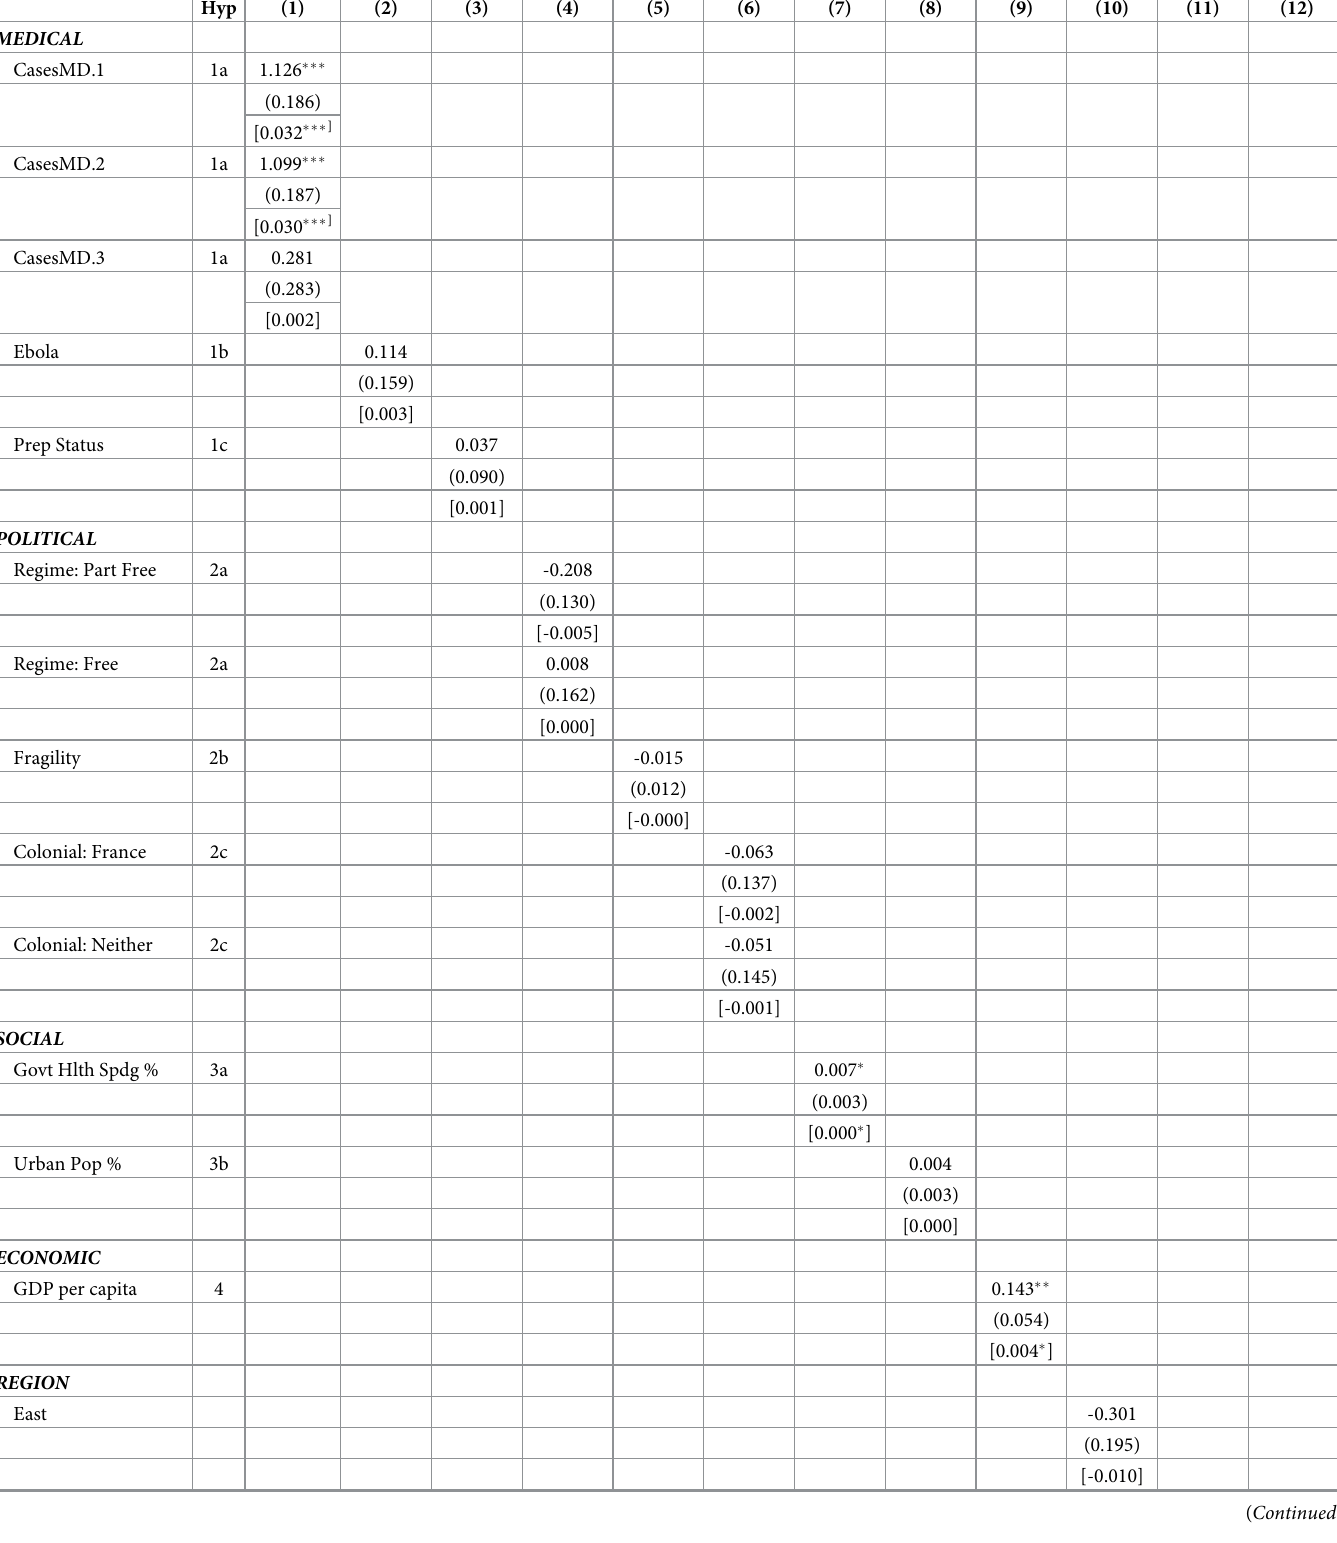
Table 3. Bivariate probit models with average marginal